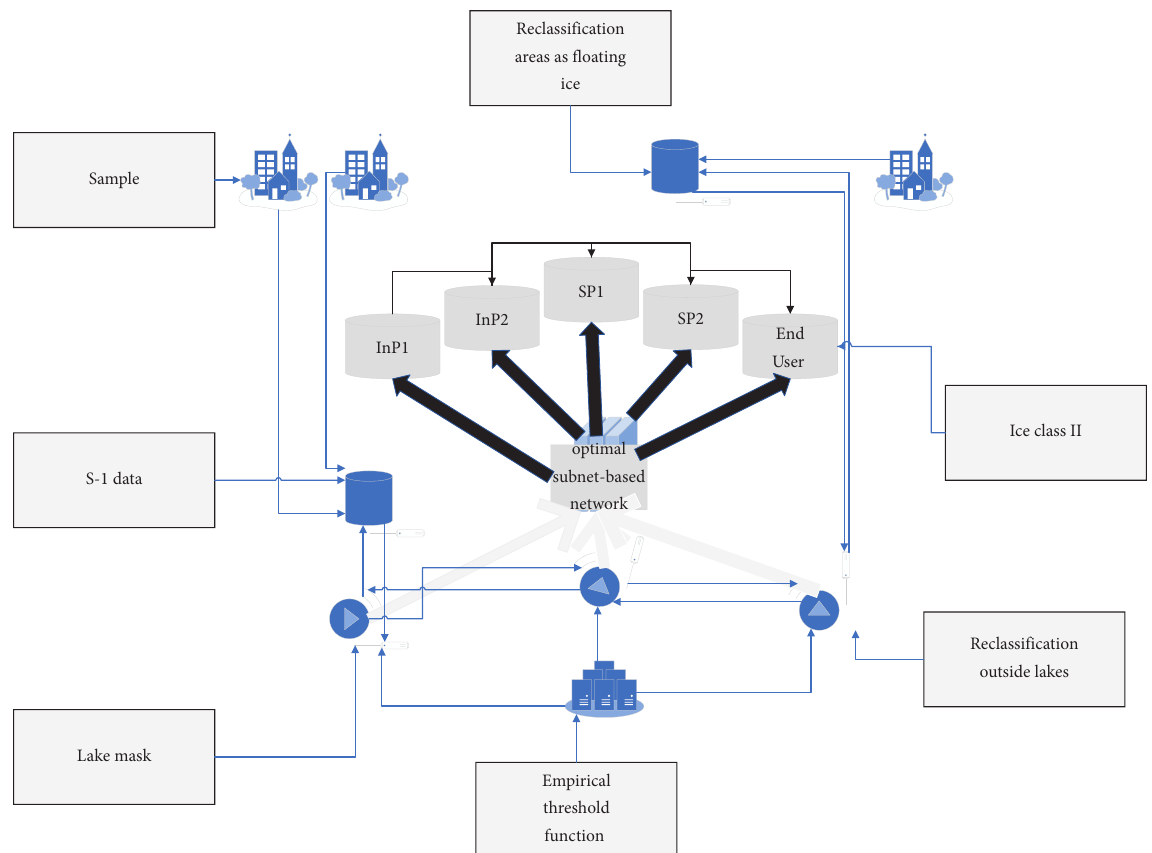
Figure 1: Optimal subnet-based network virtualization